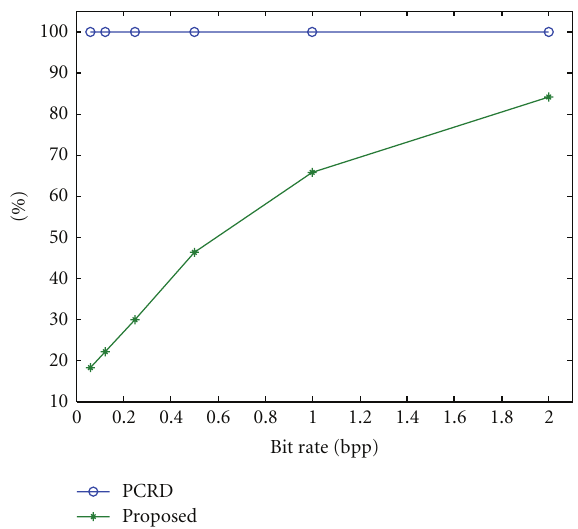
Figure 2: Average computation percentages for the PCRD and proposed algorithms.